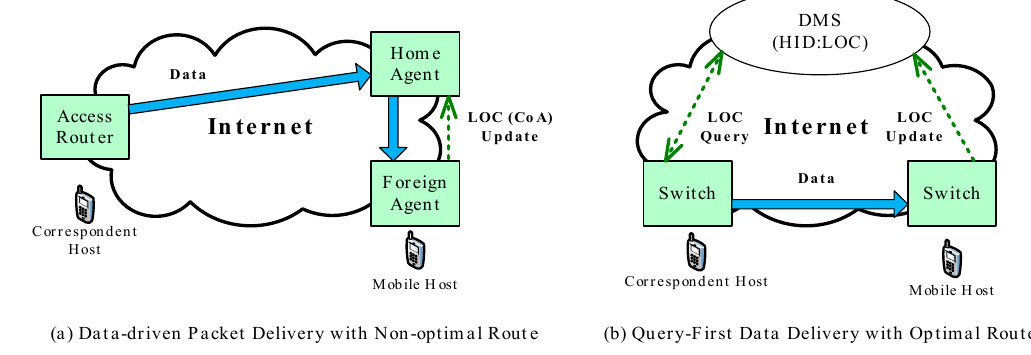
Figure 2. Data ‐ driven packet delivery versus query ‐ first data delivery.